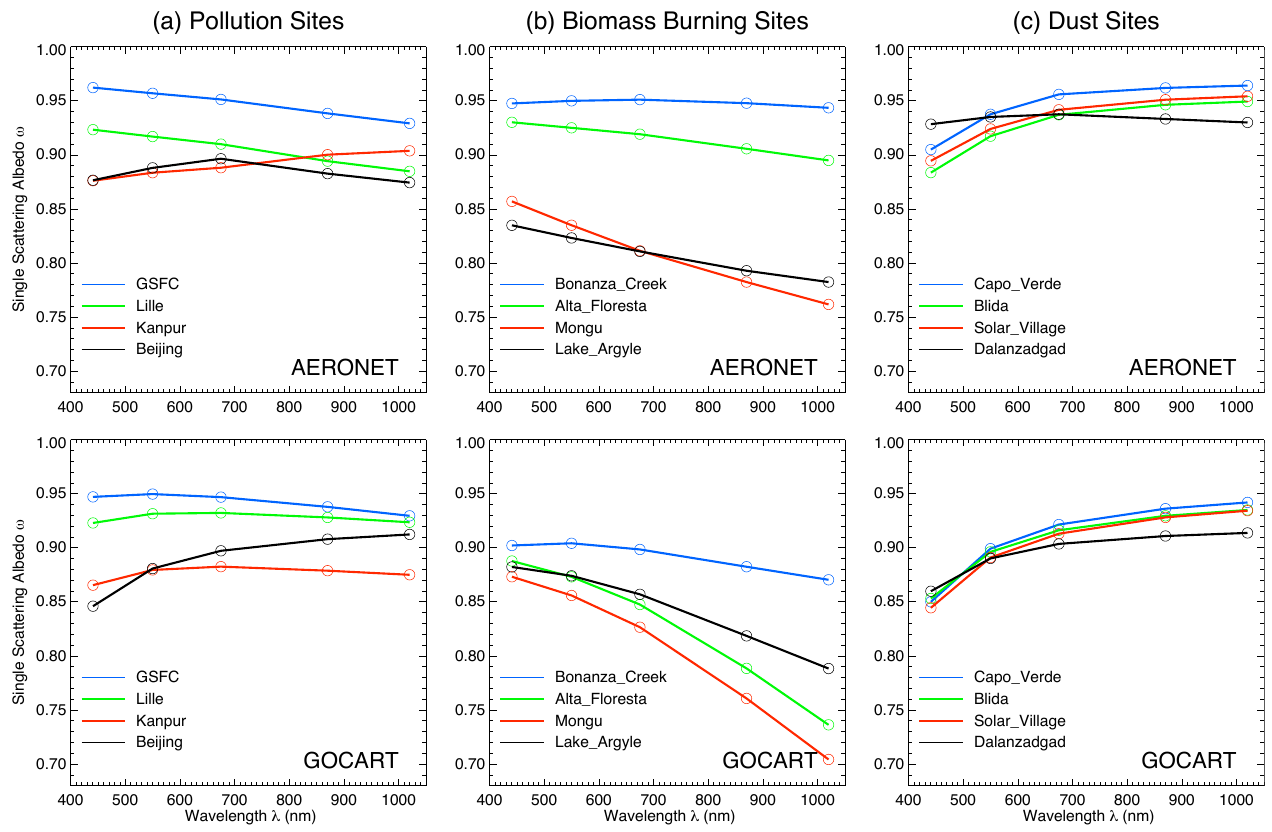
Fig. 7. Spectral dependence of ω at four sites each located at (a) pollution, (b) biomass burning, and (c) dust regions as shown in the AERONET retrieval (top row) and GOCART model (bottom row). Points are averaged over all available daily data from AERONET retrievals from 2000 to 2007. Site locations are indicated in Fig. 4 and discussed in the